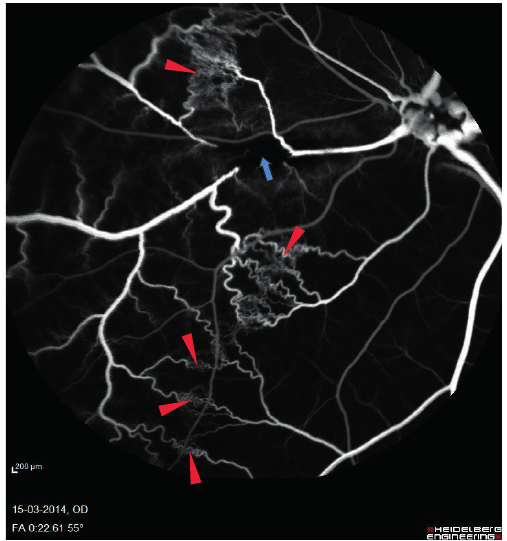
Figure 4: Peripheral haemorrhages. Peripheral haemorrhages ap- pearing upstream to the occlusion are marked with red triangle. The site of occlusion is marked with blue